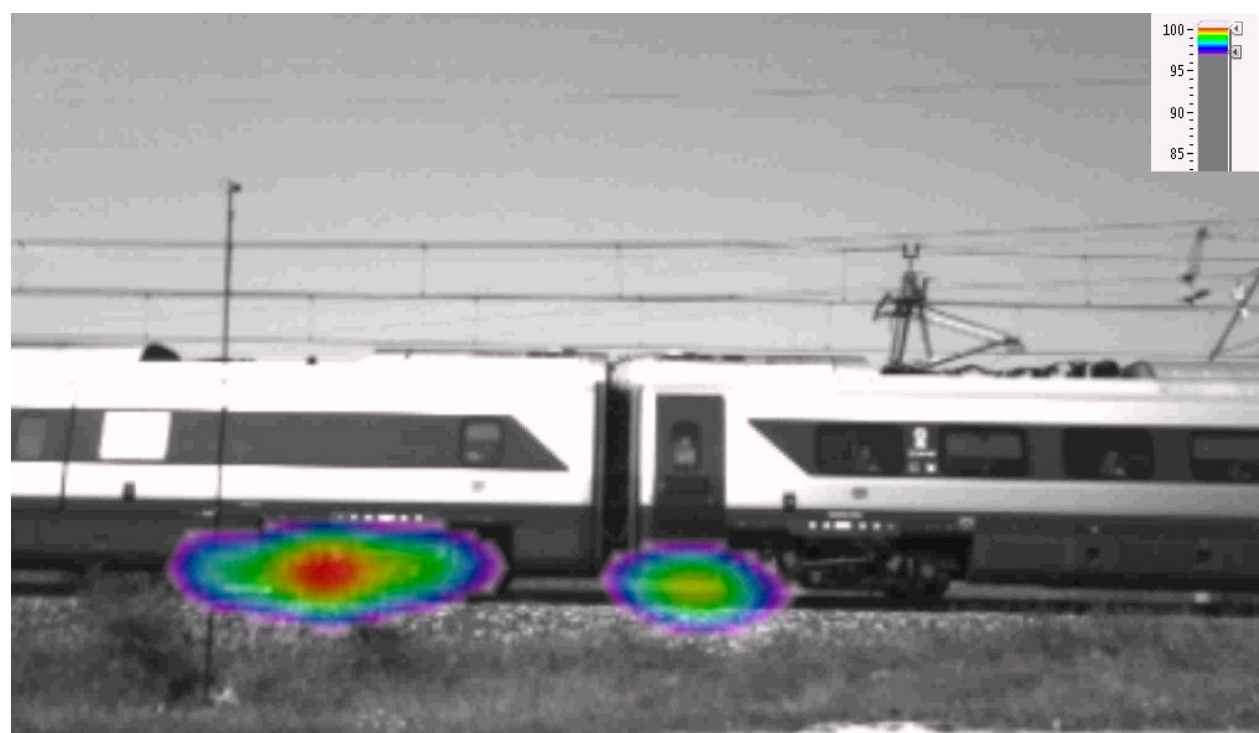
Figure 14. Sound level distribution within a frequency range of 1000–2000 Hz—curve .